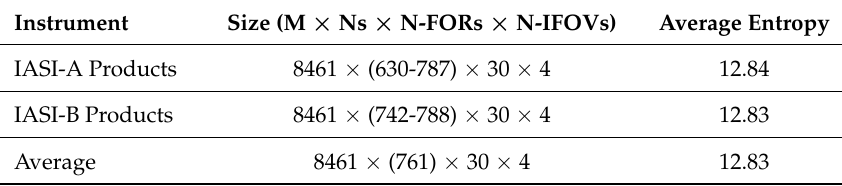
Table 7. IASI L1C products used in the experiments. Sizes and averaged zero-order entropies per instrument are provided (48 orbits per instrument). M is the number of spectral channels, Ns is the number of scan lines, N-FORs is the number of FORs per line, and N-IFOVs is the number of IFOVs per